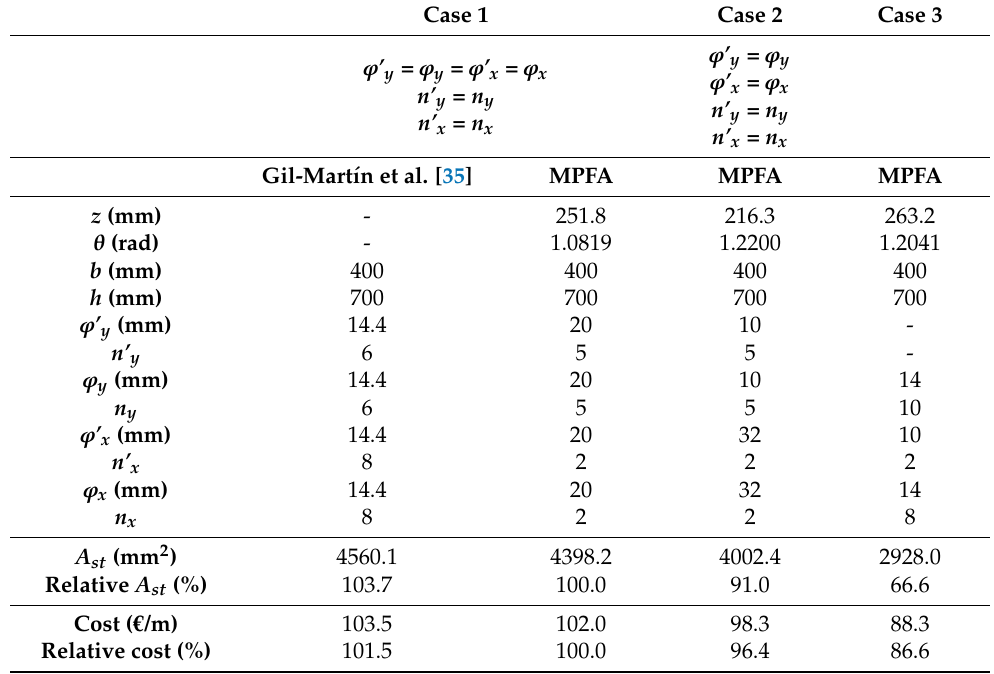
Table 5. Optimal design solutions with invariant section. EC2.